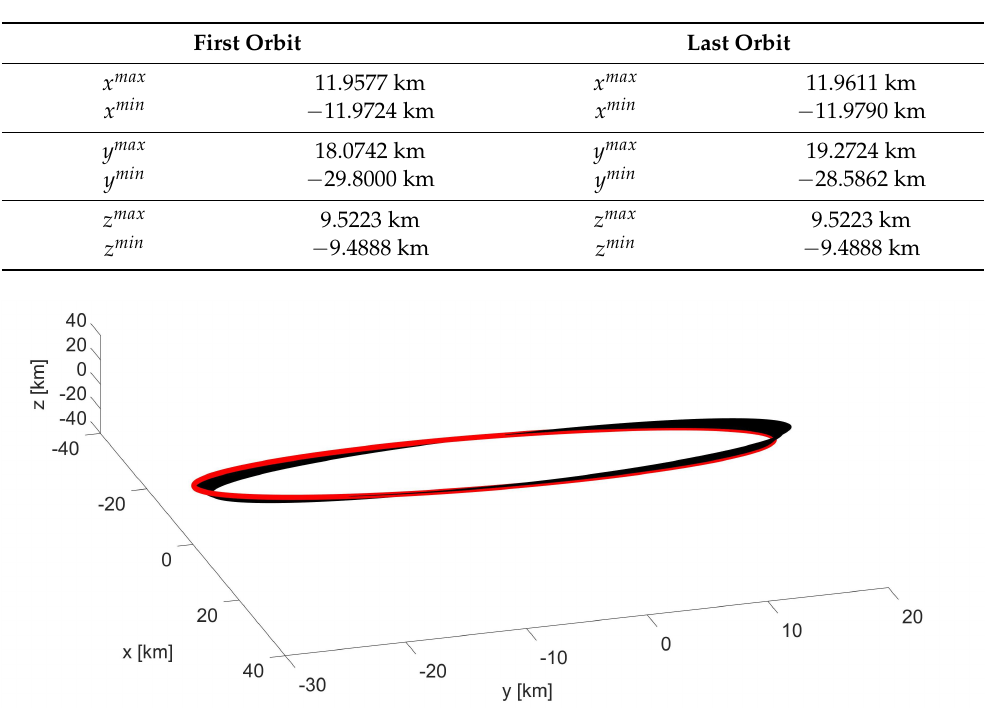
Figure 5. Mid-inclination LEO formation: J n -invariant bounded trajectory (black) in F r ; the first orbit is plotted in red.